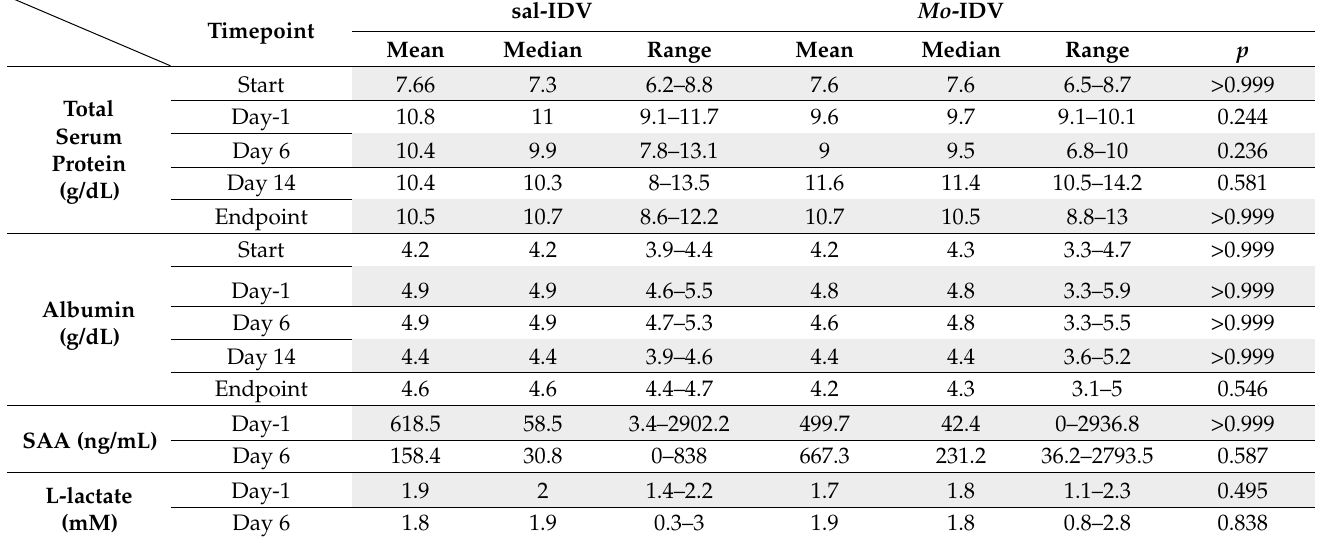
Table 2. Total serum protein and acute-phase response. Start denotes 1 day prior to M. ovipneumoniae infection. All other days relative to IDV infection. Endpoint denotes 22 days post-IDV (sal-IDV) or 23 days post-IDV ( Mo -IDV). SAA: serum amyloid A; P: Bonferroni–Dunn adjusted p -value. Comparisons evaluated by Student’s t